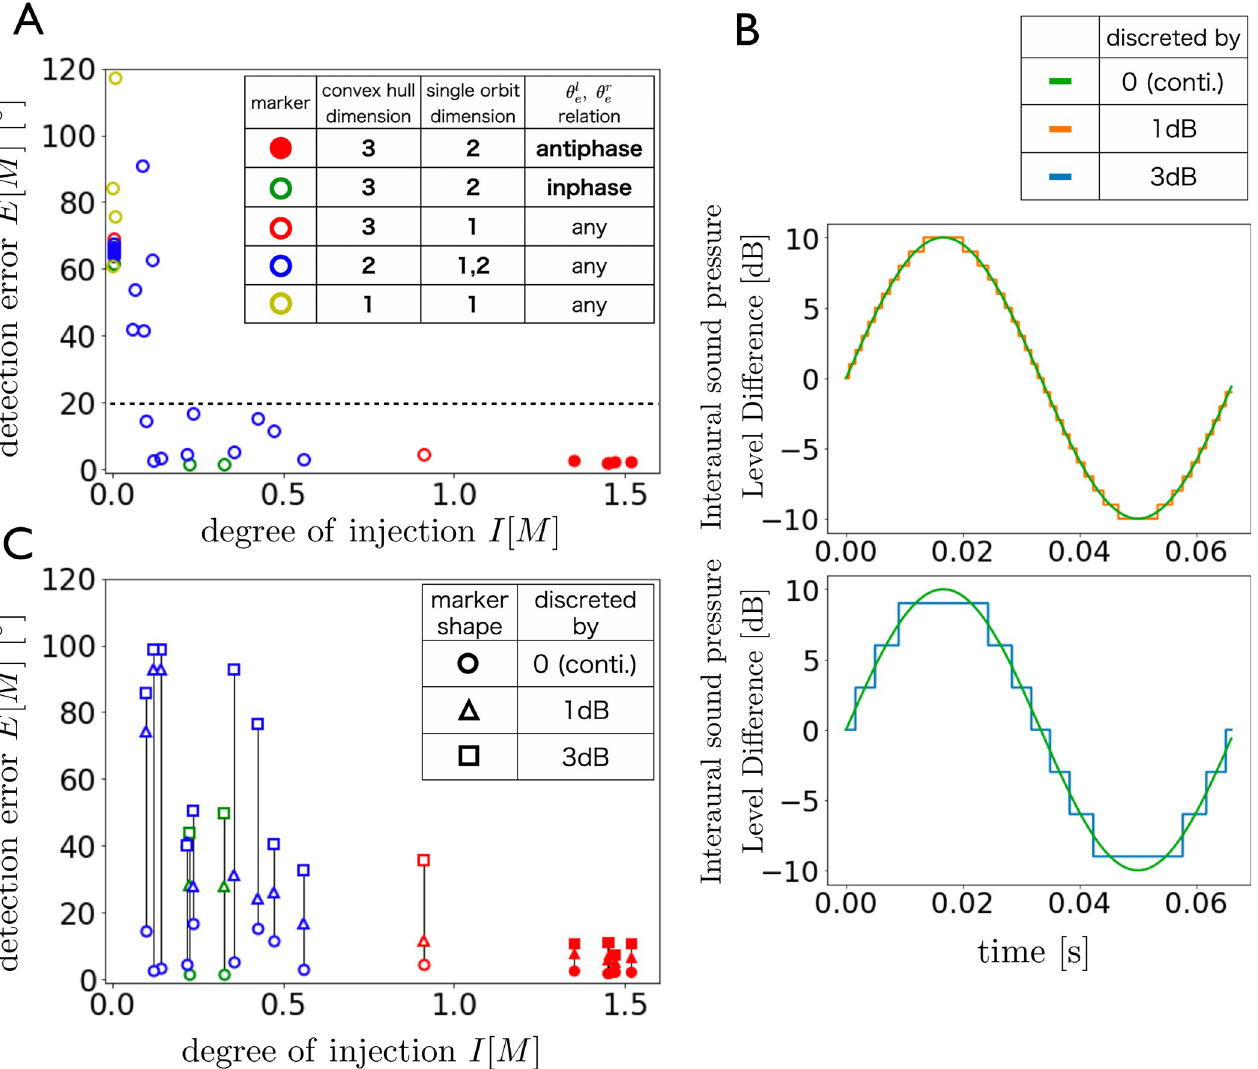
Fig 9. Relationship between I [ M ] and E [ M ] under various degradation levels of ILD resolution. (A) Relationship between the degree of injection and the detection error for the 36 ear motions without the degradation of the ILD resolution. (B) Example of change in the sinusoidal signal for each degradation level. (C) Relationship between the degree of injection and the detection error for each ear motion under the degraded ILD resolutions. Note that these evaluations were conducted for ear motions with relatively small detection errors ( E [ M ] < 20˚)in the no degradation condition (A). The length of the vertical black line corresponds to the increase in the detection error when the ILD discretization level changes from 0 dB to 3